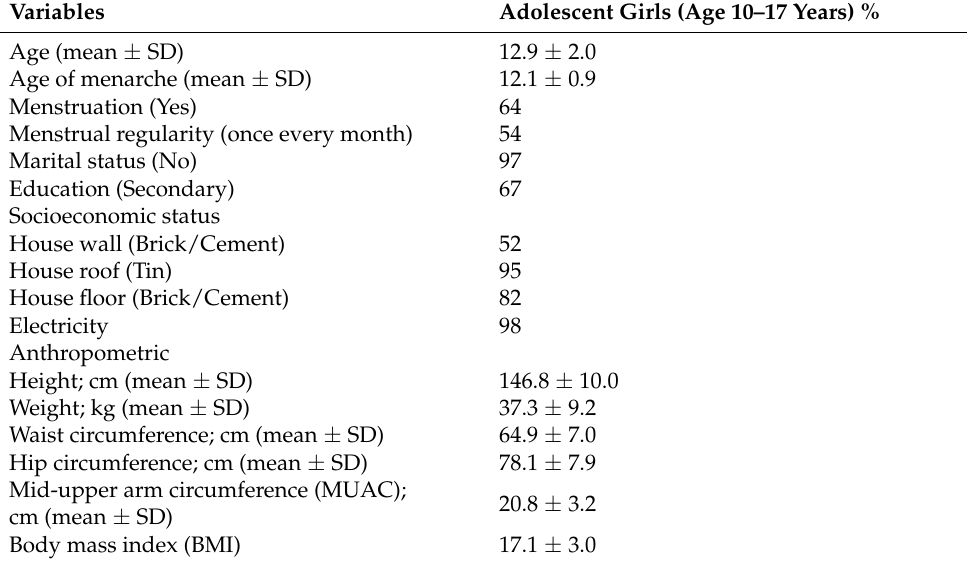
Table 2. Characteristics of the participants ( n = 100)